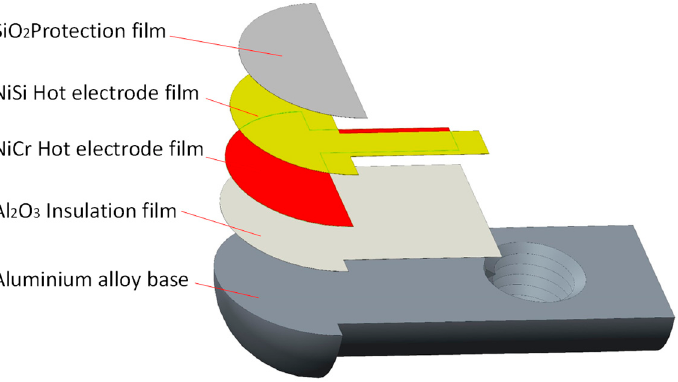
Figure 3. Schematic diagram of sensor base structure.